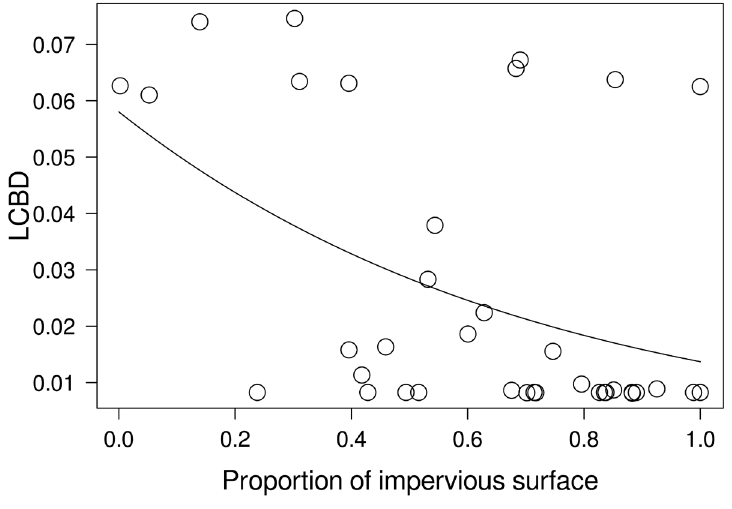
FIGURE 5 | Relationship between the local contribution to beta diversity (LCBD) and the proportion of impervious surfaces in urban streams in Cuiabá. The line indicates fitted